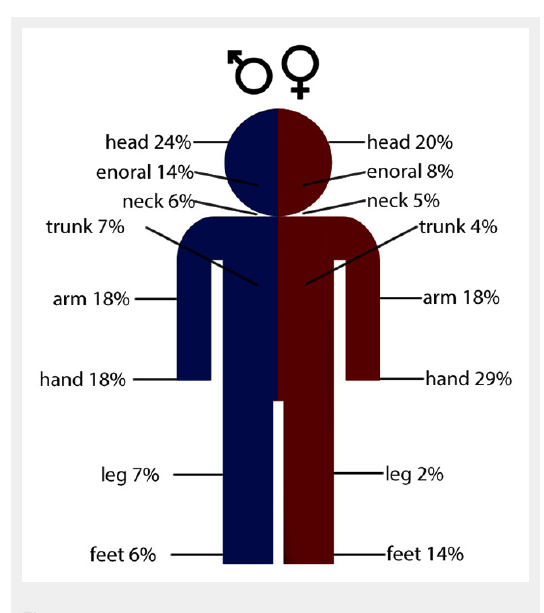
Localisation of recorded stings for each body region in men (blue) and women